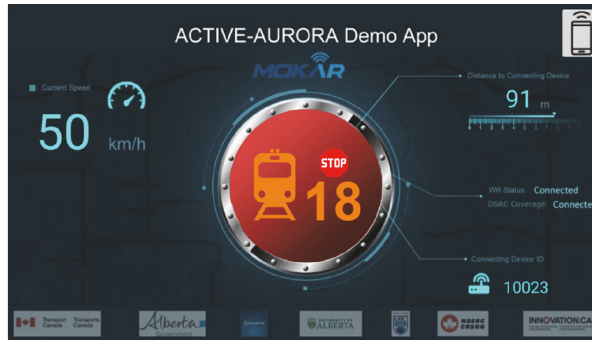
Figure 8: User interface on smart